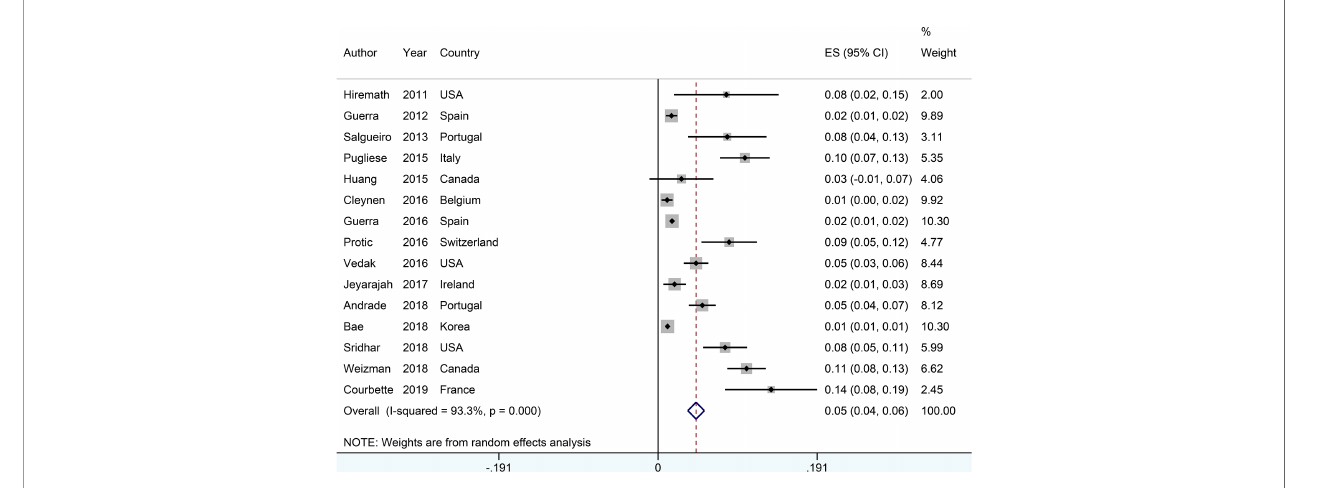
FIGURE 3 | Forest plots of incidence of psoriasis associated with anti-tumor necrosis factor therapy in in fl ammatory bowel disease